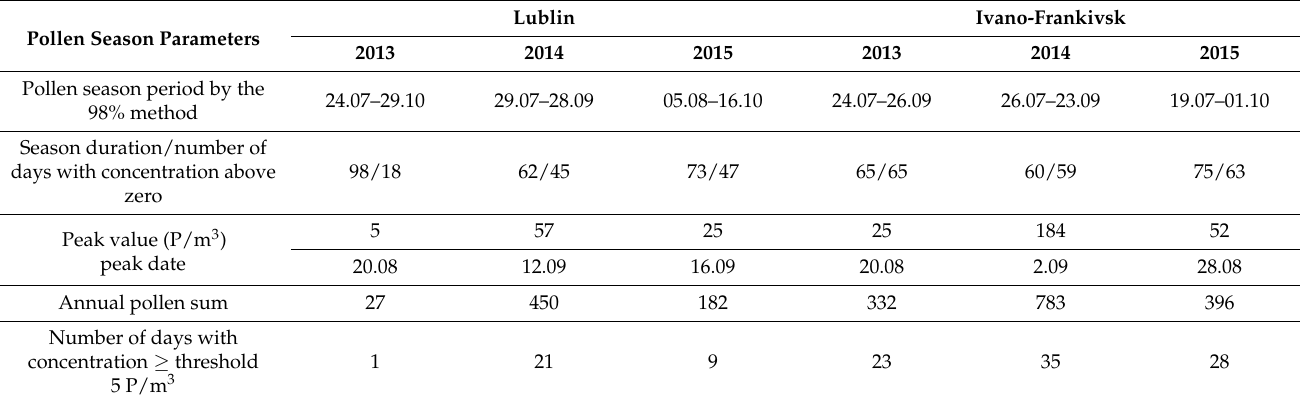
Table 1. Characteristics of Ambrosia pollen season in Lublin (Poland) and Ivano-Frankivsk (Ukraine). Pollen Season